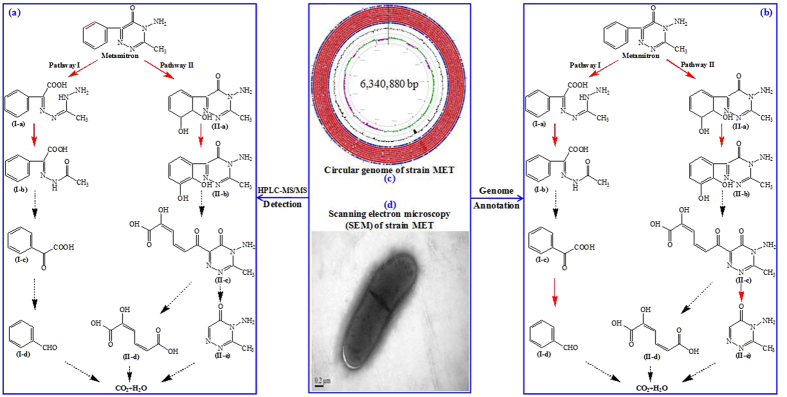
The potential degradation pathway of metamitron by the isolate MET based on genome annotation (a), the proposed degradation pathway of metamitron by the isolate MET based on HPLC-MS/MS analysis (b), circular genome of the isolate MET (c), and scanning electron microscopy (SEM) of the isolate MET (d). The reaction indicated by the full line and the dotted line represented the detected degradation step and the undetected degradation step, respectively. I-a: 2-(3-hydrazinyl-2-ethyl)-hydrazono-2-phenylacetic acid (HPA); I-b: methyl benzoylformate acetylhydrazone (MBA); I-c: benzoylformic acid (BA); I-d: benzaldehyde; II-a: 2,3-dihydro-2,3-dihydroxymetamitron (DDHM); II-b: 2,3-dihydroxymetamitron (DHM); II-c: 3-methyl-4-amino-6(2-hydroxy-muconic acid)-1,2,4-triazine-5(4H)-one (MAHT); II-d: 2-hydroxy-muconic acid; and II-e: 3-methyl-4-amino-1,2,4-triazine-5(4H)-one (MAT).